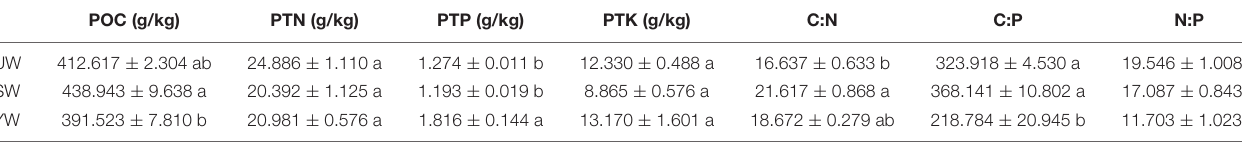
TABLE 1 | Effects of geographical location on leaf nutrient elements in G. uralensis .